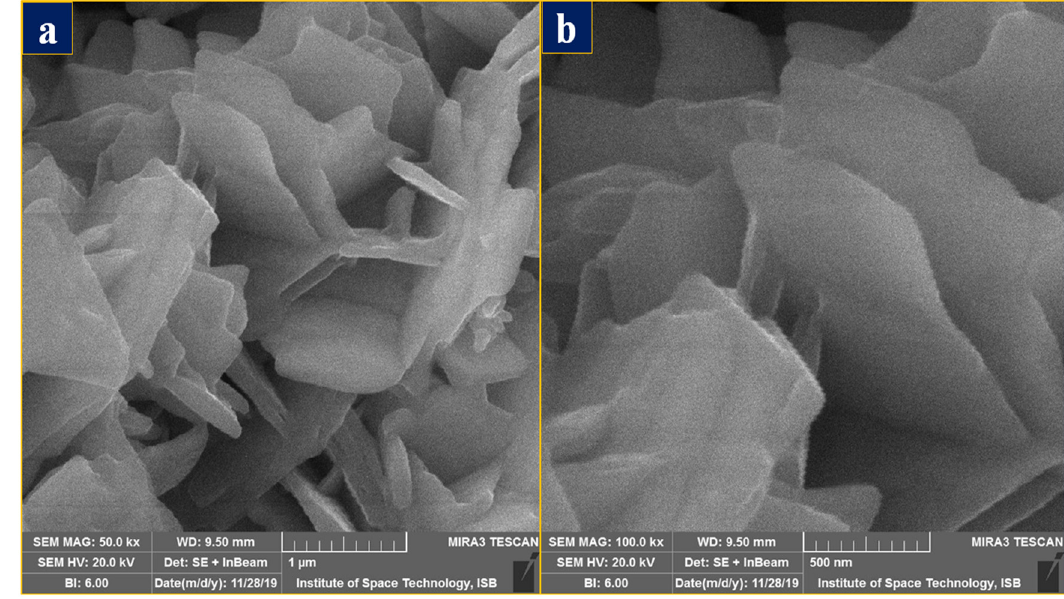
Figure 2: FESEM ( a ) low - and ( b ) high - resolution images of CuO